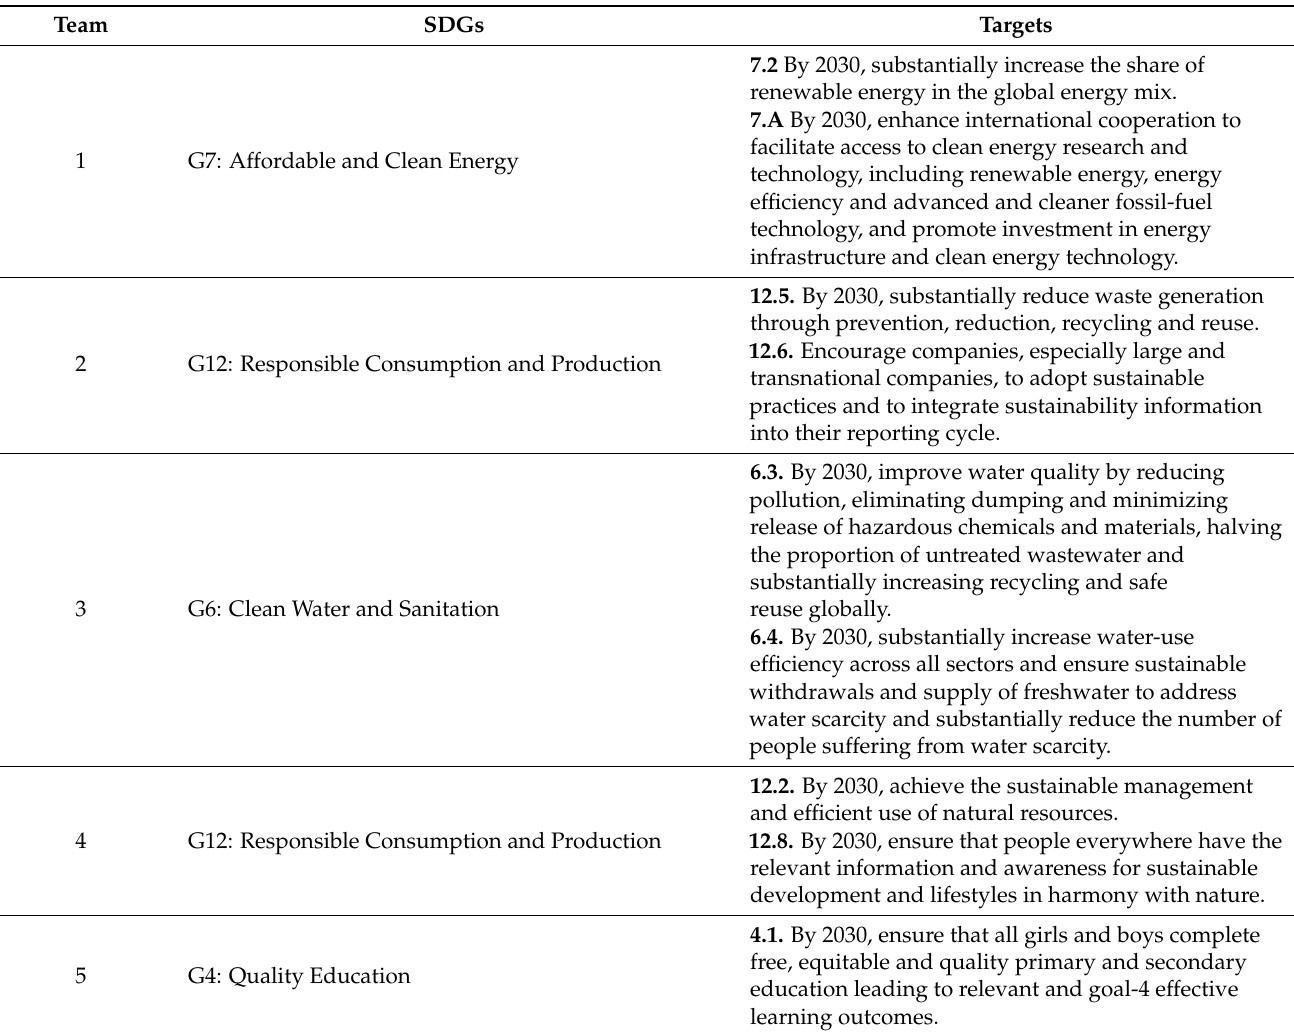
Table 3. SDGs and targets worked by the different work